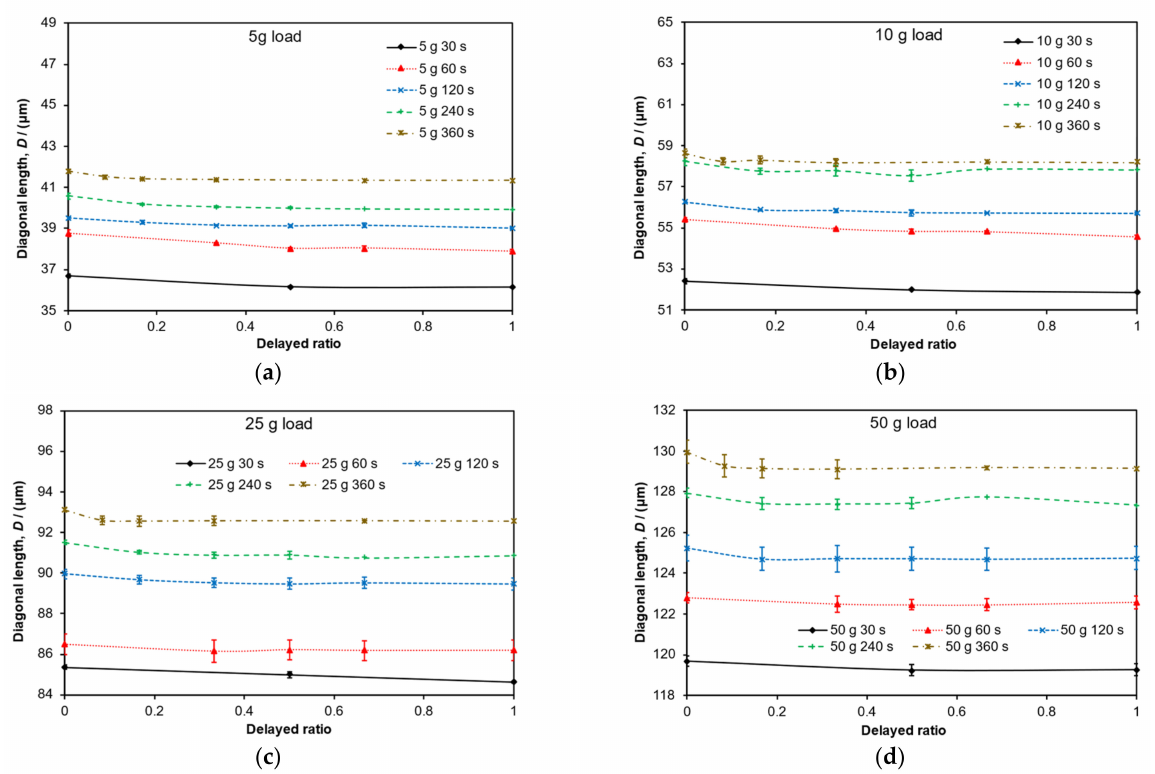
Figure 4. Relationship between the recovery of the diagonal length versus delayed ratio: Loads levels of ( a ) 5 g, ( b ) 10 g, ( c ) 25 g and ( d ) 50 g are shown with the corresponding dwell times. Error bars represent standard errors. Trendlines connecting the data points are